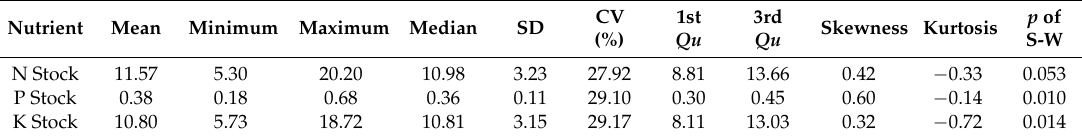
Table 1. Summary of statistics of soil N, P, and K stocks within 0–60 cm (Mg ha − 1 ).